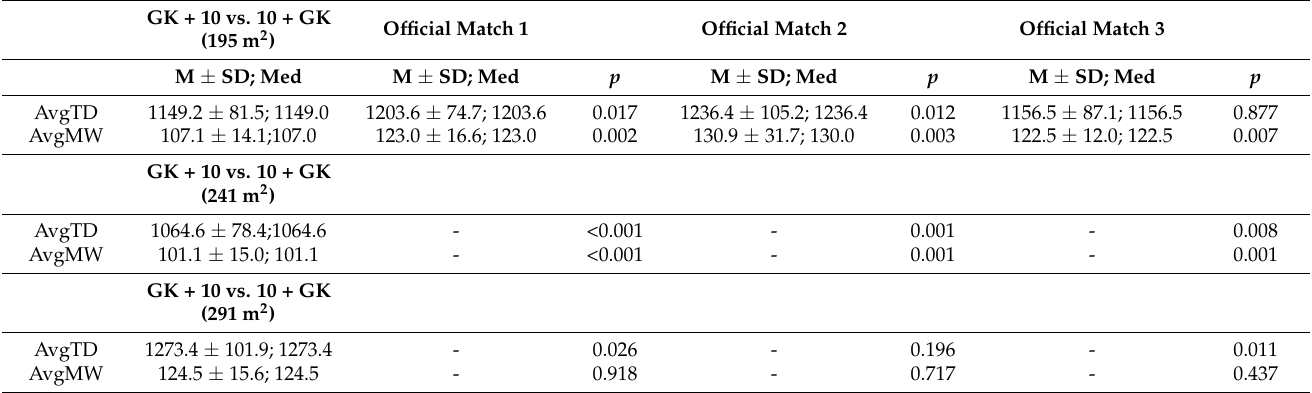
Table 4. Individual differences in the scores of the locomotor intensity between each LSG condition and the official